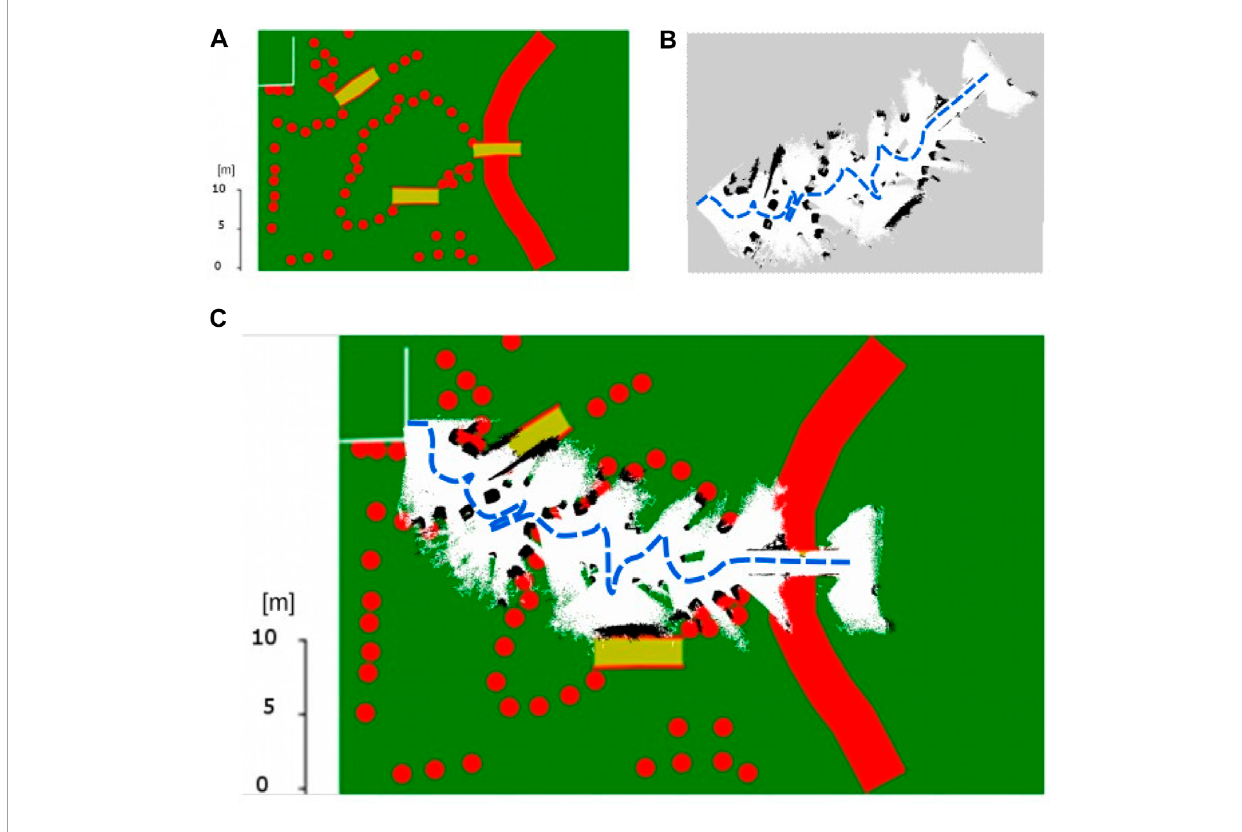
FIGURE 13 (A) Map provided by ESA at the beginning of the mission. (B) Map created by one rover during the mission. (C) Map of the lunar environment of the challenge overlaid with the map generated by the REALMS rover. The two maps are matching, showing the solution is accurate.